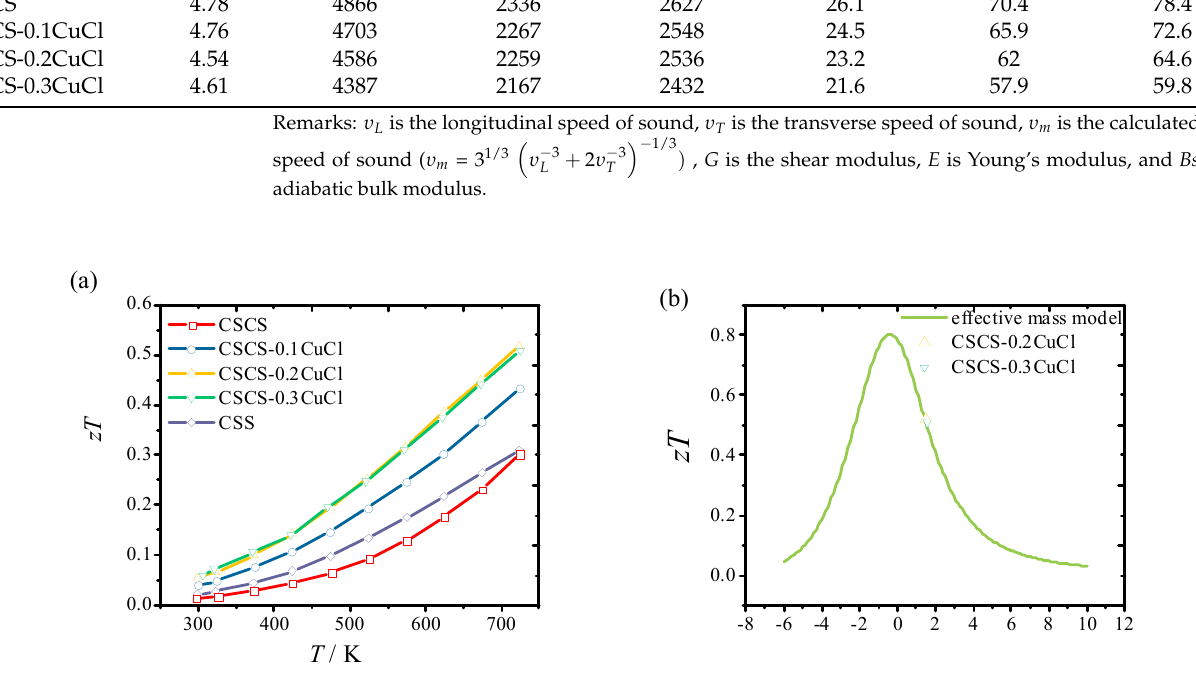
Figure 6. ( a ) Figure of merit, zT , as a function of temperature for the pristine CSS and CSCS- x CuCl ( x = 0, 0.1, 0.2, 0.3) samples and ( b ) effective mass model derived zT against the reduced chemical potential at 700 K for CSCS- x CuCl ( x = 0, 0.2, 0.3) samples.